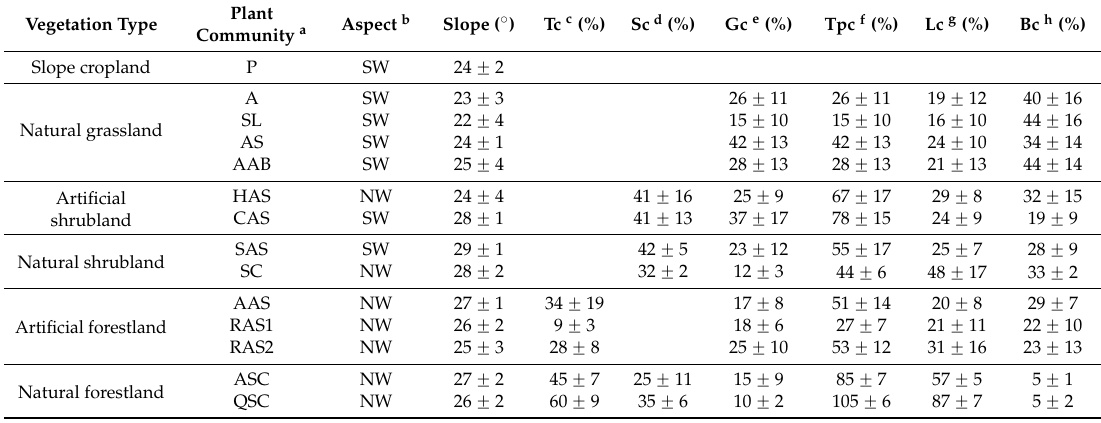
Table 1. Sites conditions and the cover of different layers of plant